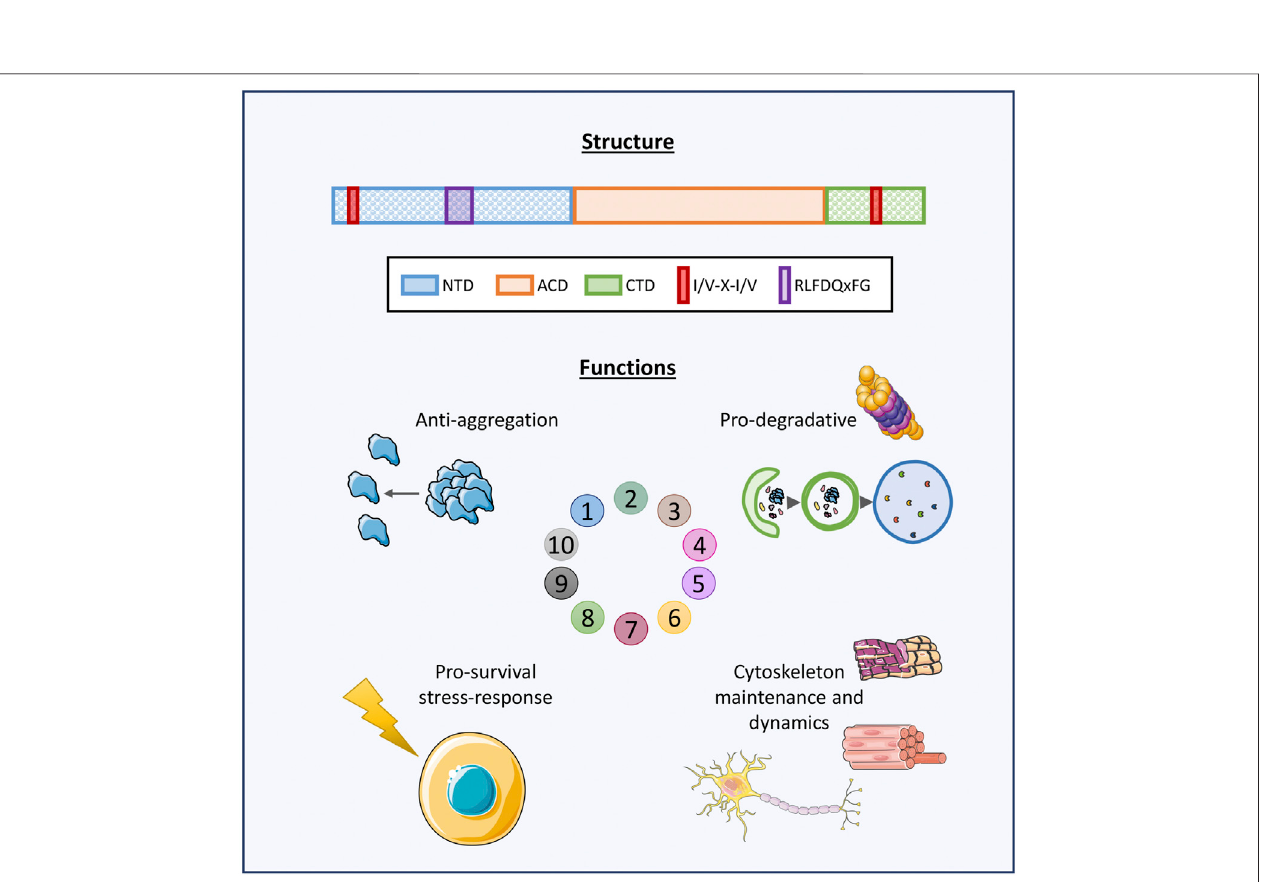
FIGURE 1 | Graphical representation of HSPBs structure and main functions. Schematic representation of human HSPBs structure, from Cristofani et al. (2021). The orange box represents the conserved α -crystallin domain (ACD); the blue and green boxes represent the variable N-terminus and C-terminus domains (NTD, CTD, respectively);theredboxindicatestheI/V-X-I/V domainslocalizingattheNTDand/orCTDinseveralHSPBs;thepurpleboxindicatestheRLFDQxFGmotifconservedin HSPBs. HSPBs functions include i) anti-aggregation activity against misfolded and aggregation-prone substrate and ii) cooperation with the degradative systems for substrate disposal, iii) protection against stressors and antiapoptotic activities, iv) cytoskeletal maintenance and dynamics. Servier Medical Art templates, which are licensed under a Creative Commons Attribution 3.0 Unported License were used in this fi gure;